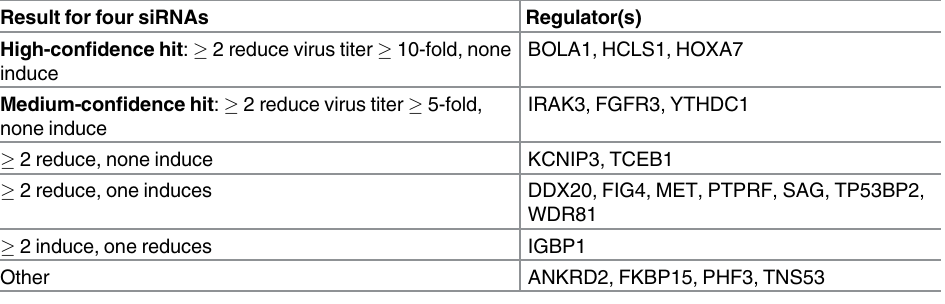
Four siRNAs were used per gene. siRNA results are reported for signi fi cant changes in viral titer as assessed by T-test compared to negative control. Hits are de fi ned as those that show a strong, signi fi cant and consistent effect across multiple siRNAs. Full data and results are available in S7